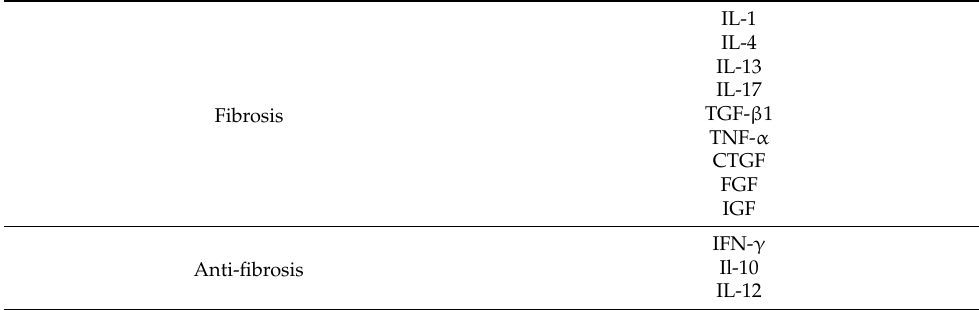
inhibit fibrosis, but the detailed mechanisms are not clear. Table 2. Major molecules involved in fibrosis or